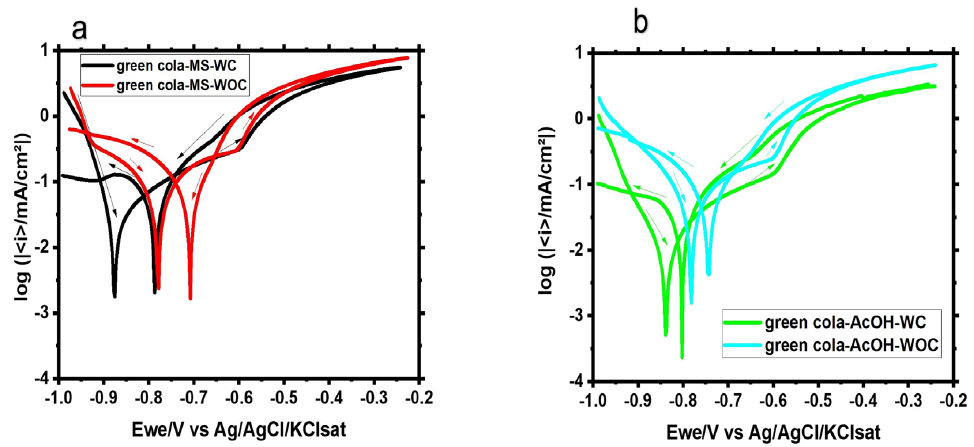
Figure 7. Cyclic potentiodynamic curves for the Green Cola samples with (WC) and without (WOC) an organic coating studied in ( a ) the main solution of the soft drink and ( b ) acetic acid; Ewe: working electrode potential.